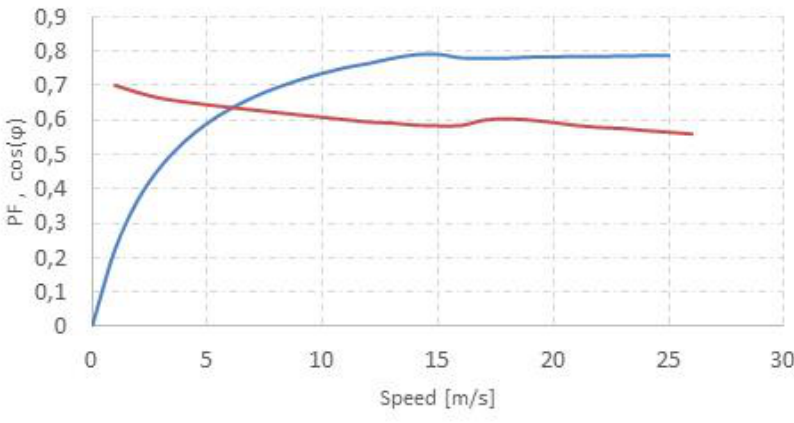
Figure 16. Power factor and efficiency curves for one example of a traction LIM.